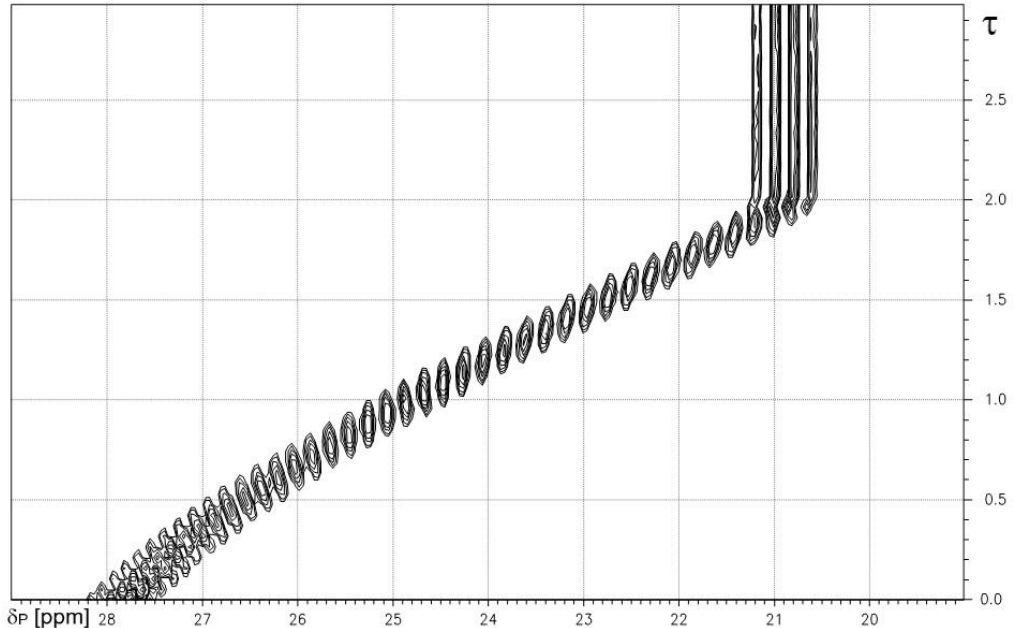
Figure 1. 1 H-coupled 31 P-NMR-controlled titration of methanephosphonic acid 1 vs. NaOH. Note: quartet fine structure from X-part of AX 3 system of P-CH 3 fragment. X -axis: δ P [ppm]. Y -axis: degree of titration τ . Table 2. Specific chemical shifts δ C , δ P and coupling constants 1 J PC and 2 J PH of methanephosphonic acid 1 were obtained by 13 C{ 1 H}-, 31 P{ 1 H}-, and 31 P-NMR-controlled titrations in H 2 O. Δ i = δ (H n-i L) − δ (H n+1-